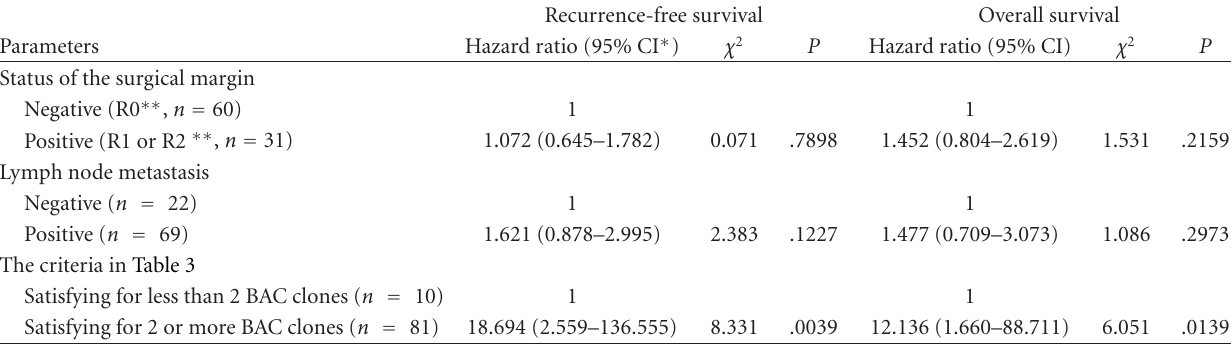
Table 4: Multivariate analysis of clinicopathological parameters and DNA methylation profiles associated with recurrence-free and overall survival in patients with ductal adenocarcinomas of the